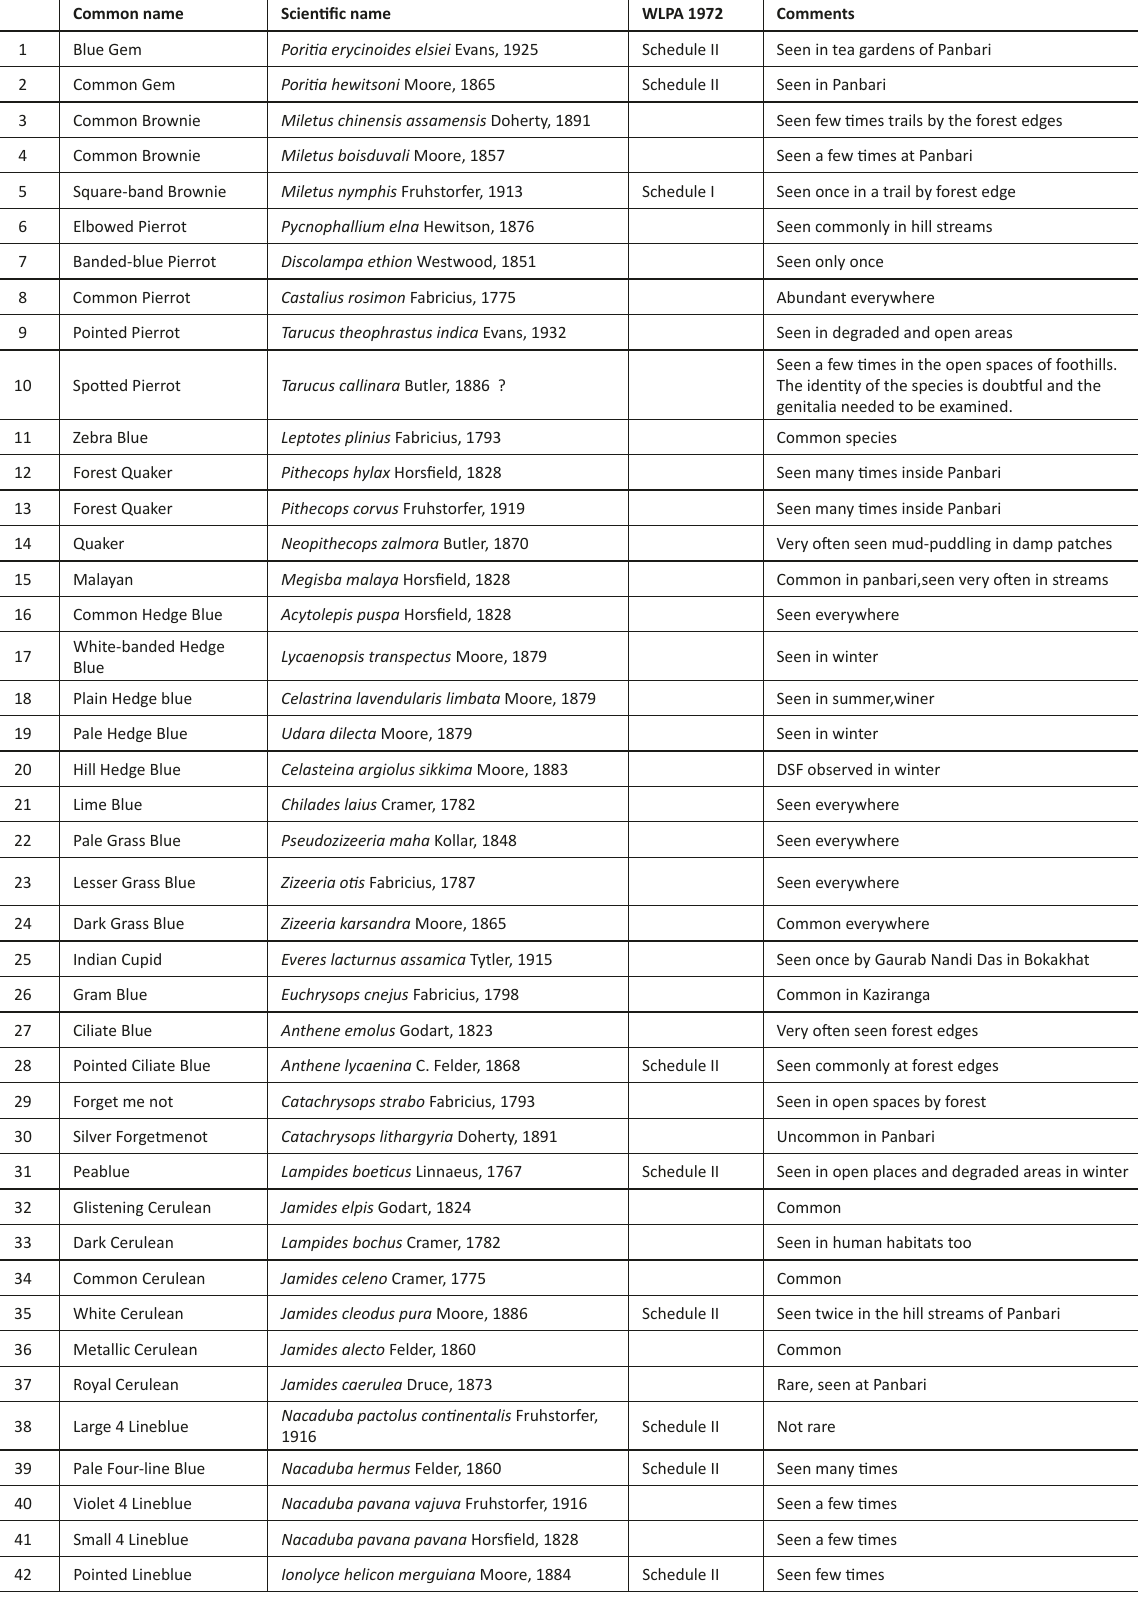
Table 1. A preliminary checklist of Lycaenidae recorded in Panbari forest of Kaziranga and neighbouring areas of Karbi Hills